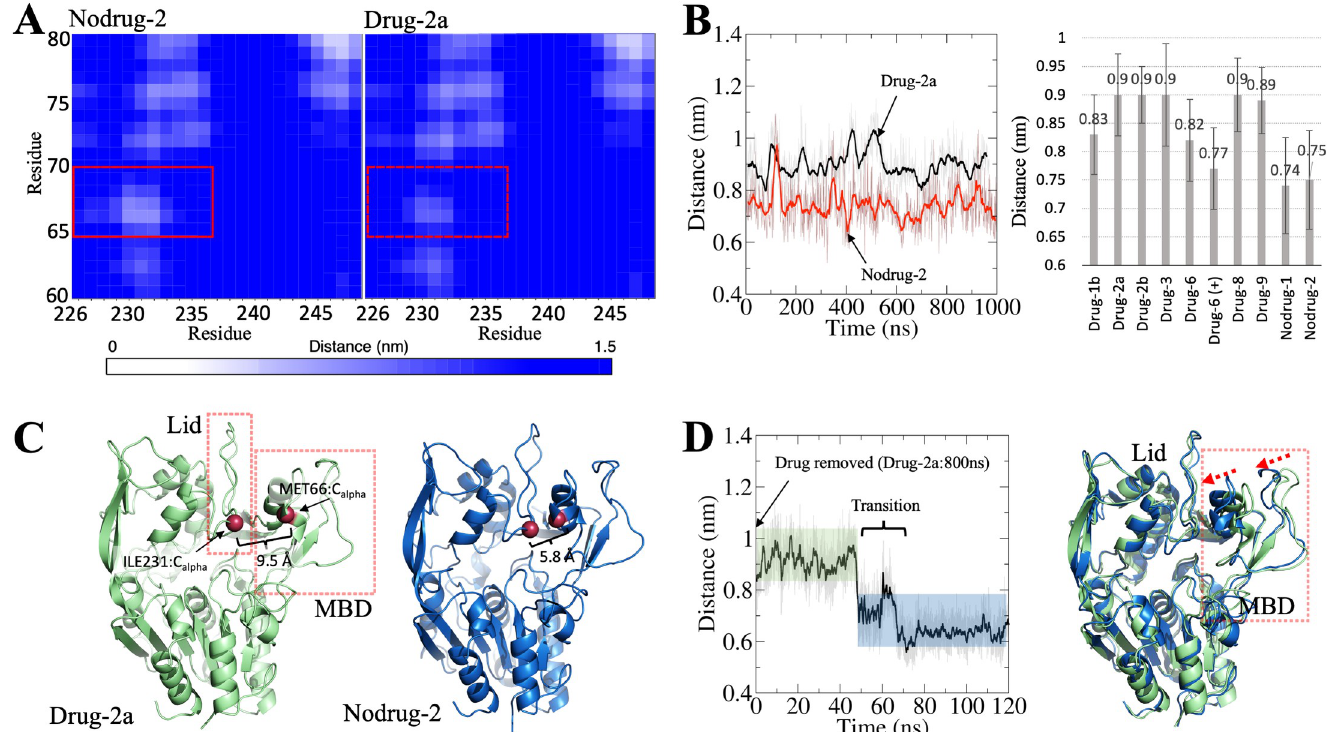
Fig 4. (A) The average distances between the relevant residues mapped as a distance matrix plot. Drug 2a is used as an example as the rest of the compounds induced a similar change. (B) The distance between the α -carbon atoms of M66 and I231 as a function of time in Drug-2a and Nodrug-2 simulations (Left). The average distances between the α -carbon atoms of M66 and I231 for all simulated systems (Right). (C) Snapshots from Drug-2a and Nodrug-2 simulation showing the maxima and minima of the detected conformational change. The proteins are rendered as cartoons and the marker residues’ α -carbons as red spheres. (D) The distance plot derived from the simulation where compound 2a was removed from the allosteric site after 800 ns (Left). Two simulation snapshots superimposed showing the orientation of the MBD domain before (0 ns; green) and after the removal of compound 2a (120 ns; blue) (Right).